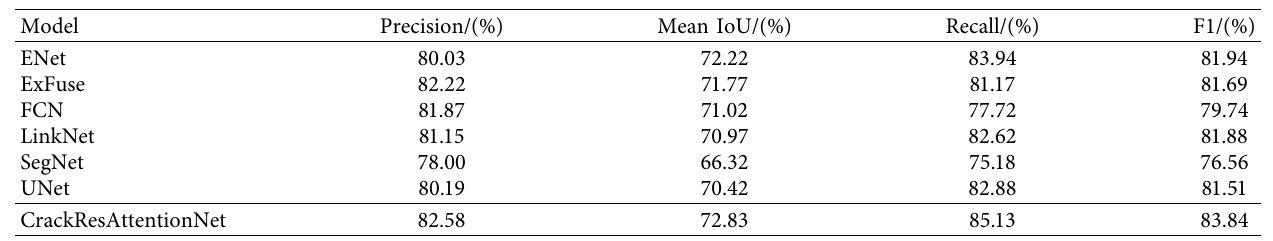
Table 3: Public Crack Dataset- CE loss.